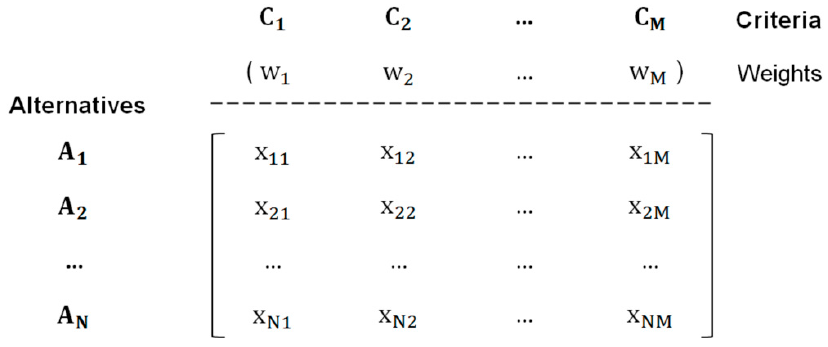
Figure 3. Decision matrix of a typical MCA model, characterized by N alternatives (A i ) and M criteria (C j ); each criterion is associated with a weight of importance (w j ). The elements, x i , denote the score of alternative A i when it is evaluated in terms of the criterion C j .